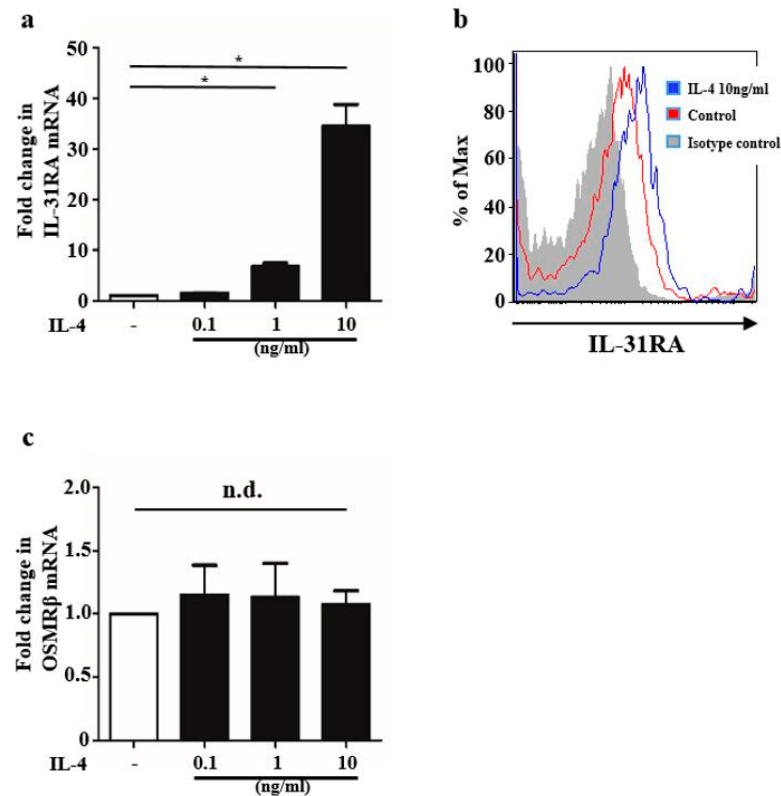
Figure 1. IL-4 stimulation upregulated IL-31RA expression in bone marrow-derived dendritic cells (BMDCs). ( a , c ) Data are expressed as mean ± standard error of the mean (S.E.M.); n = 3 for each group; * p < 0.05. Expression of IL-31RA ( a ) and OSMR β ( c ) mRNA in BMDCs stimulated with IL-4 (0.1, 1 and 10 ng / mL) for 24 h. mRNA levels normalized for ACTB are expressed as fold induction compared with that in the control group. ACTB was utilized as a housekeeping gene. ( b ) BMDCs were treated with or without IL-4 (10 ng / mL) for 24 h. IL-31RA expression was evaluated using anti-murine IL-31RA antibody. Data are representative of experiments repeated three times with similar results.